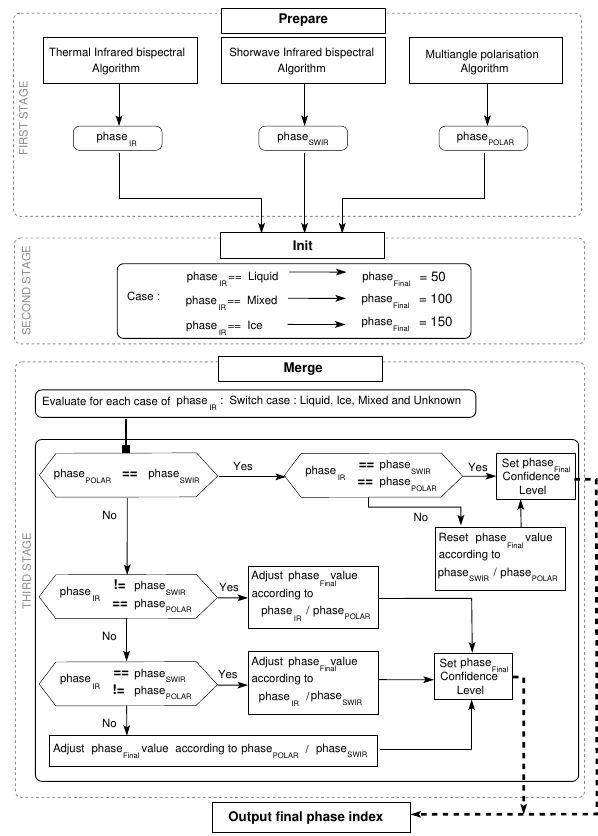
Fig. 4. Flowchart of the merging algorithm and decision tree used to produce the final cloud phase